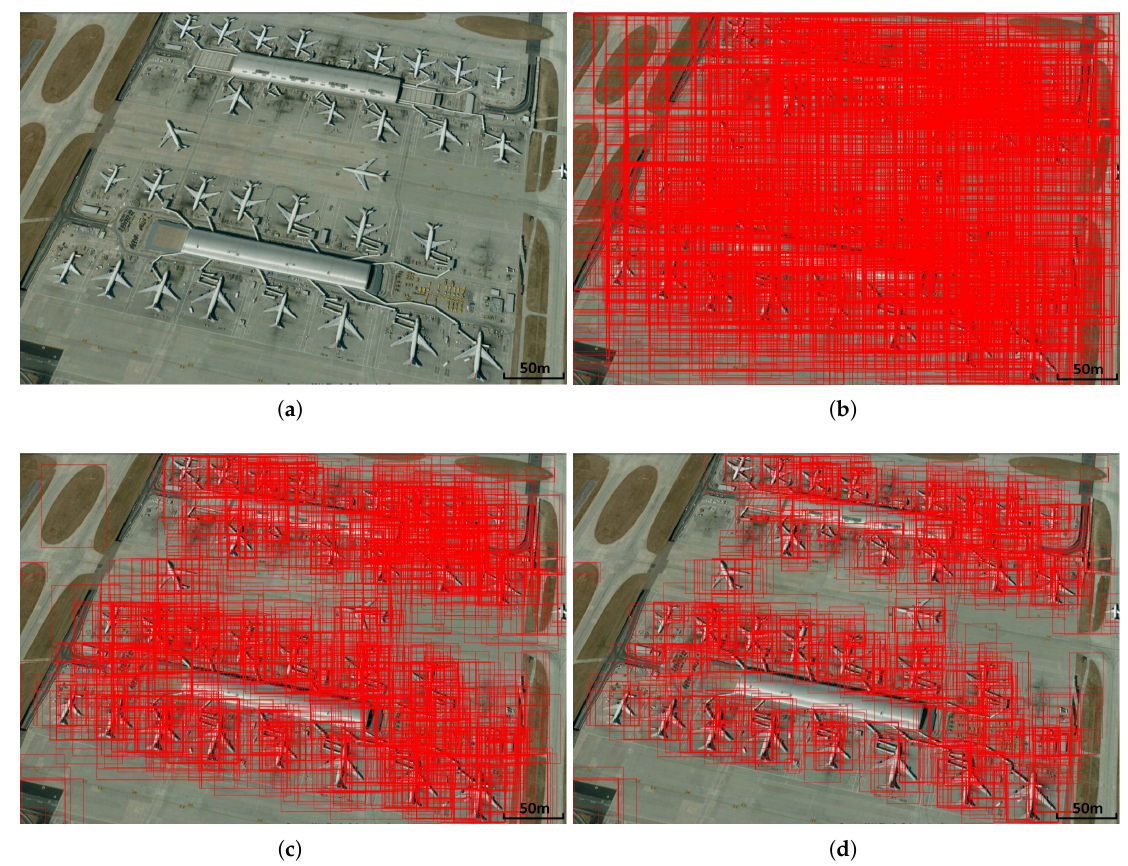
Figure 4. Display of the results through different methods that extract candidate boxes. All results are located with red bounding boxes. ( a ) the original remote sensing image; ( b ) the results generated by EdgeBoxes [29]; ( c ) the results generated by CEdgeBoxes [6]; and ( d ) the results generated by the restricted